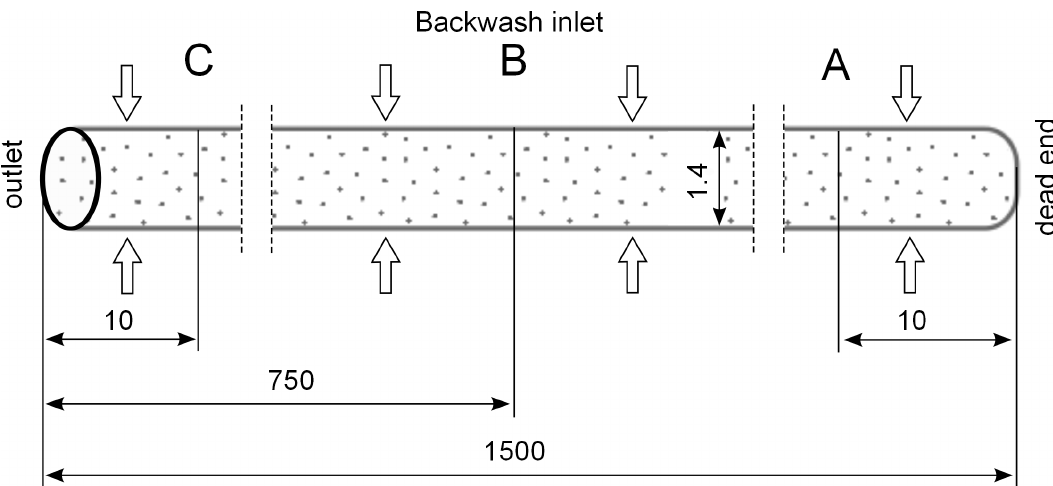
Figure 2. Positions of control lines (A, B, C) for the evaluation of velocity and particle distribution during